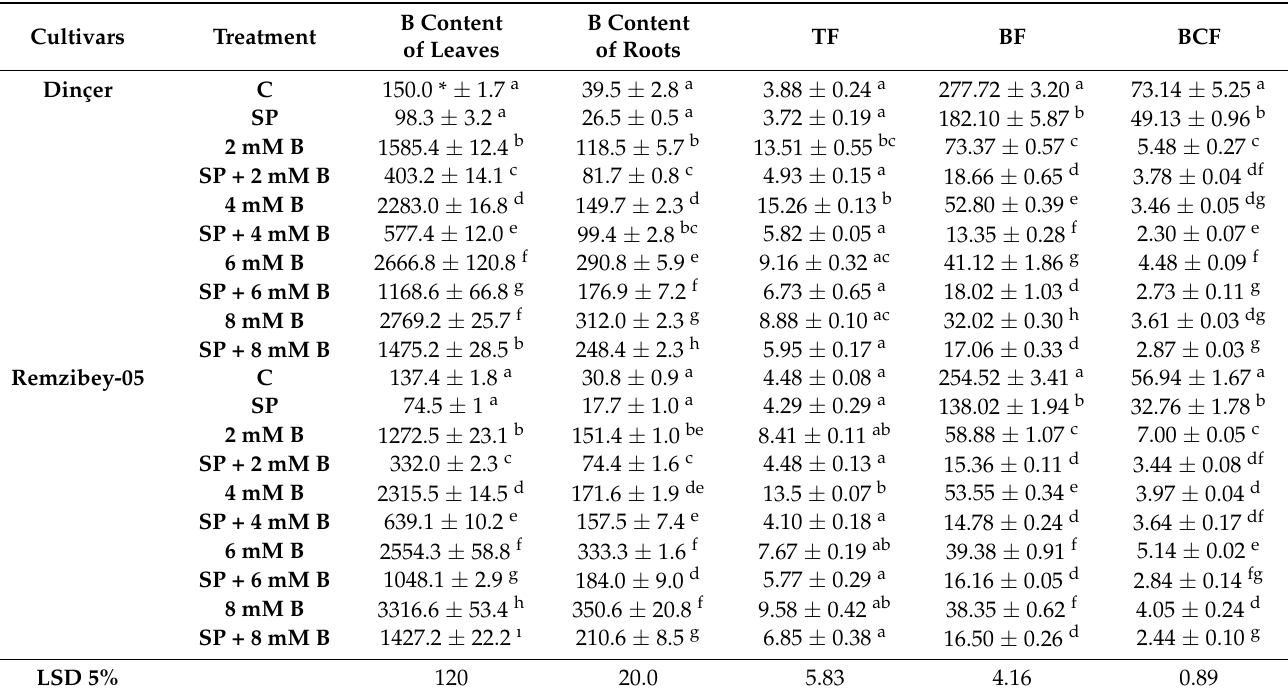
Table 1. Boron contents (mg kg − 1 DW) of leaves and roots of safflower cultivars exposed to toxic B with or without SP and calculated translocation factor (TF), bioaccumulation factor (BF), and bioconcentration factor